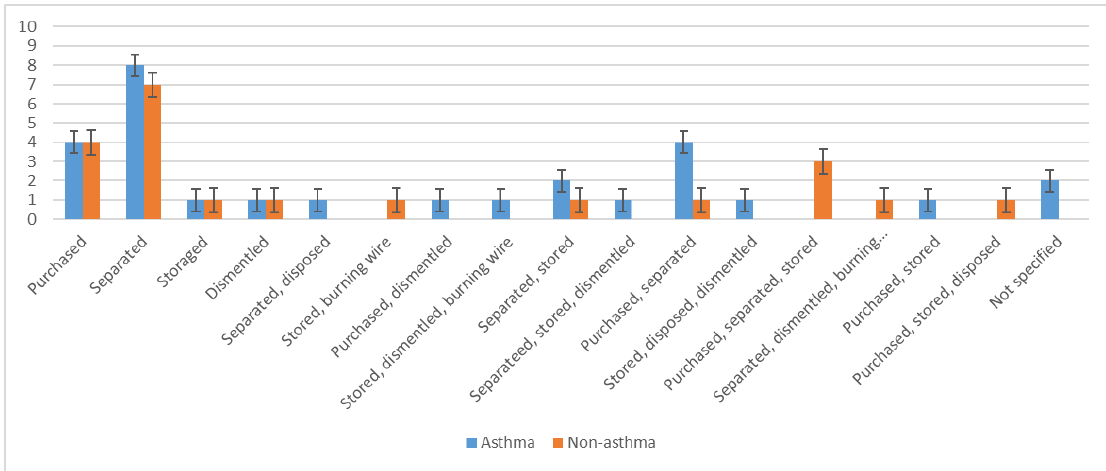
Figure 2. Participant involvement in electronic waste (e-waste) activities, stratified by asthma status.